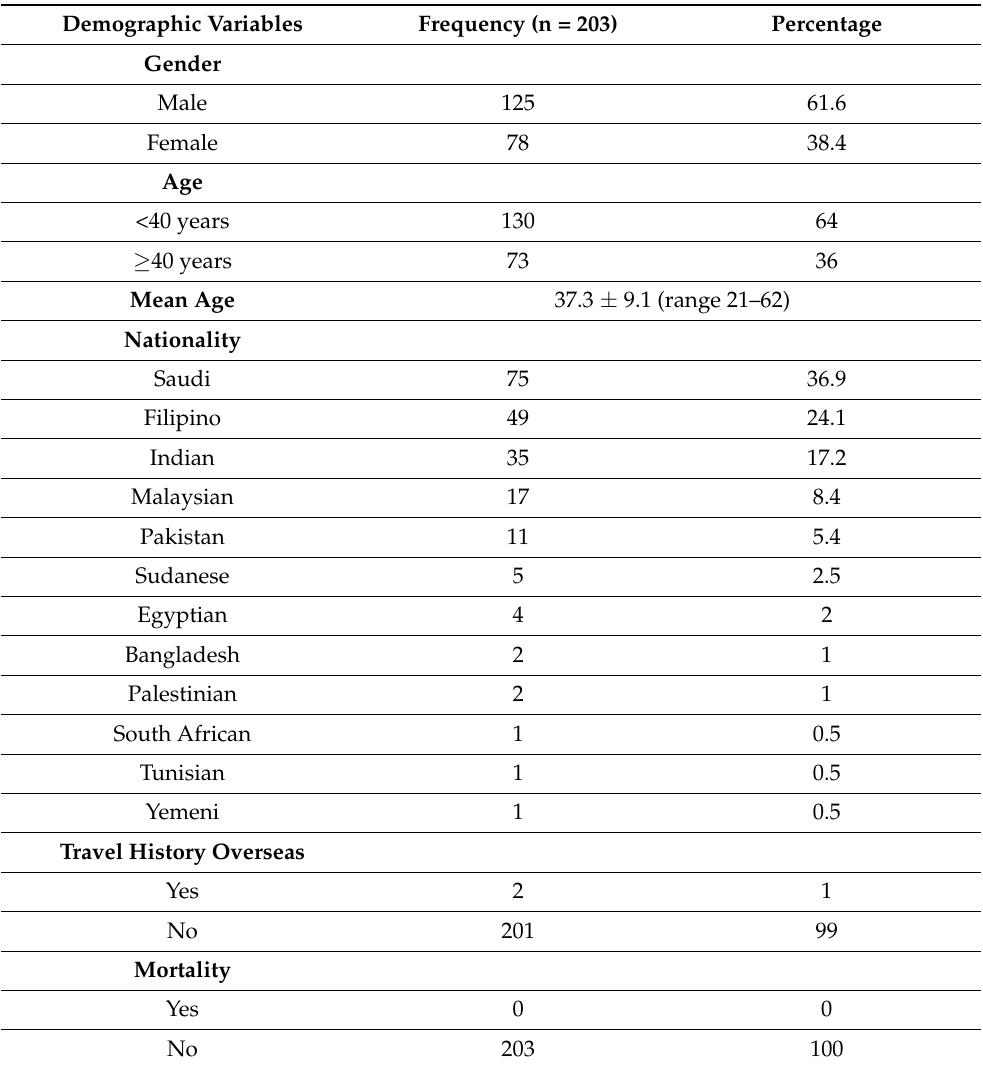
Table 2. Demographic characteristics of the study